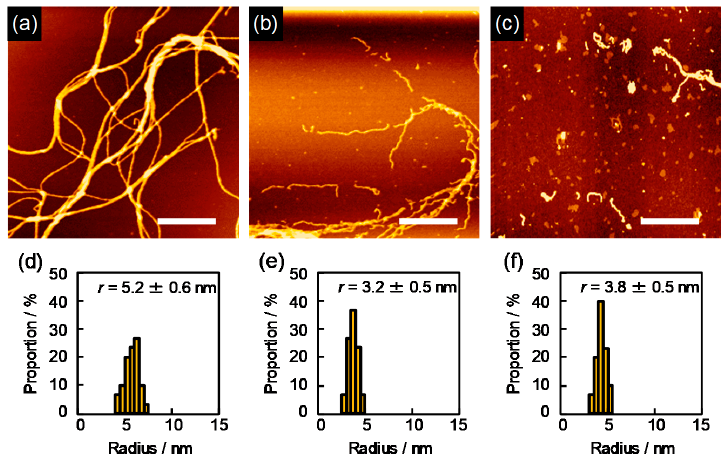
Figure 10. ( a – c ) AFM topographic images and ( d – f ) the radius distributions of the nanowires from a drop-cast film of 1, 3, 5-tris[(3- methylphenyl) phenylamino] benzene isolated via sequential development. The film was irradiated with 490 MeV 192 Os 30+ ions at the fluence of 2.0 × 10 8 cm − 2 and developed by ( a , d ) n -hexane at 60 °C, followed by ( b , e ) CHCl 3 for 10 s and then ( c , f ) CHCl 3 for 2 min. Scale bars represent 500 nm. Reproduced with permission from ref. [112] ©2016, Royal Society of Chemistry.